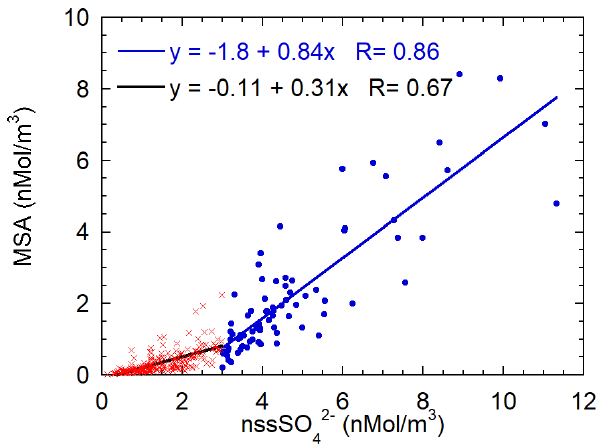
− . The 4 concentra- 4